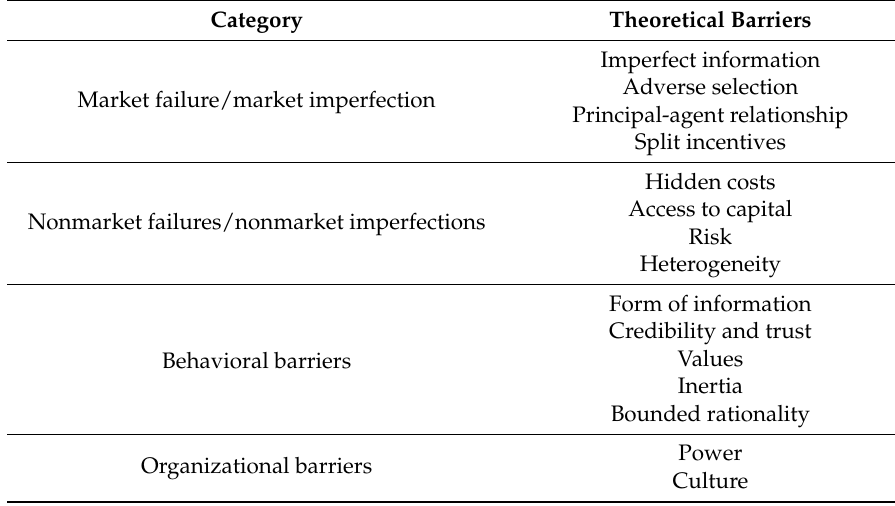
Table 1. Barriers to energy efficiency according to Sorrell et al.